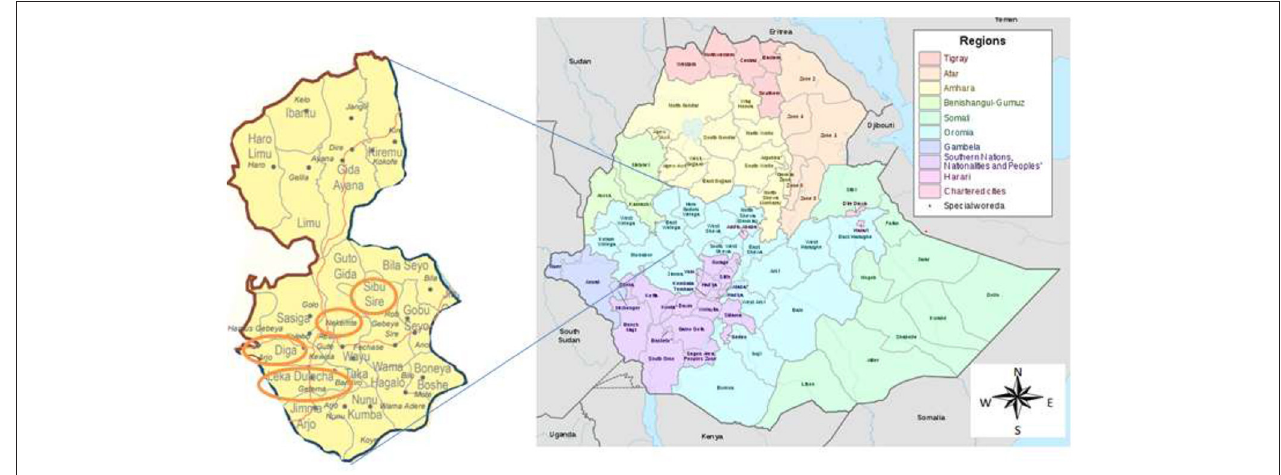
FIGURE 1 | Map of the study